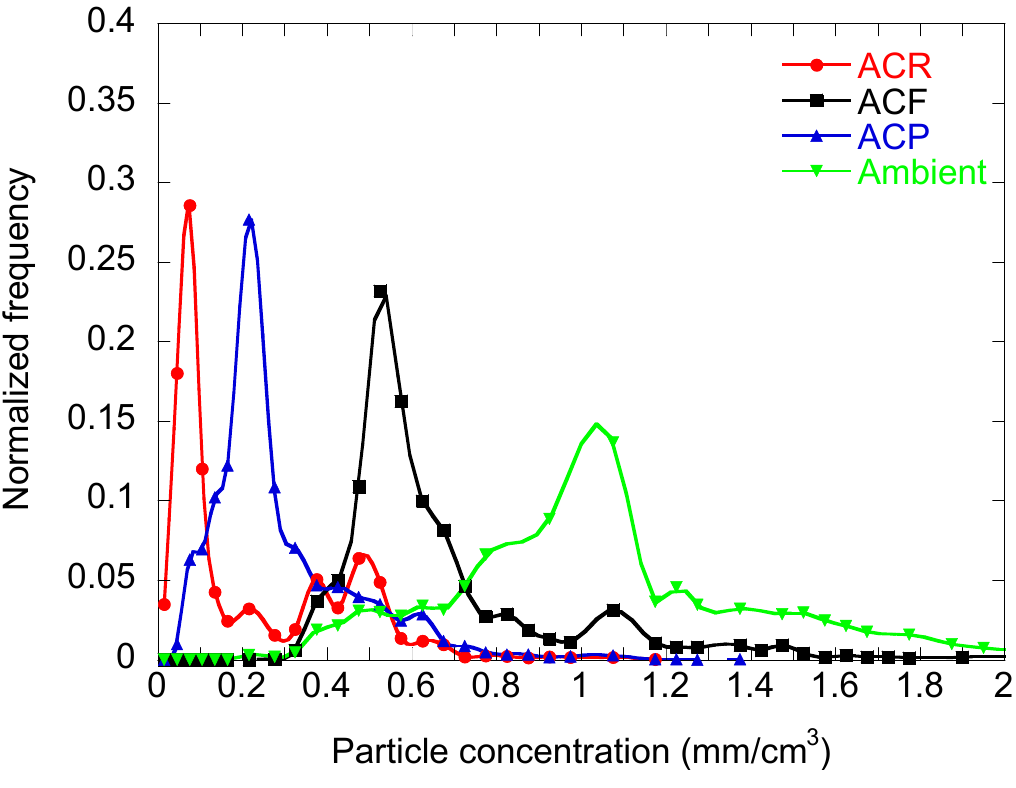
Figure 8. Normalized frequency plot of particle surface area concentrations, corresponding to the diffusion charger signal, during the highway test. The ambient condition was measured with two front windows fully opened.